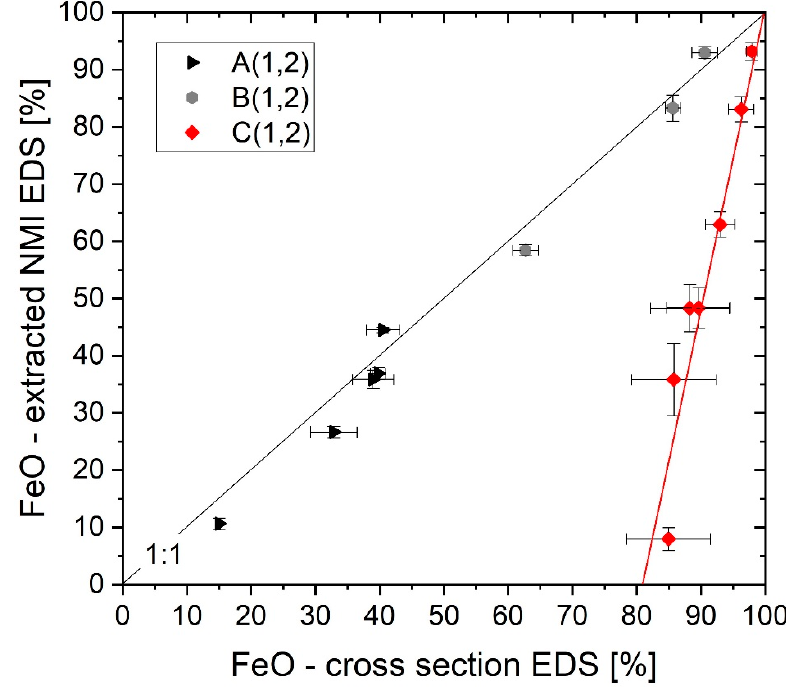
Figure 9. Referencing cross-section with extracted nonmetallic inclusions (NMI) single-point EDS measurements.